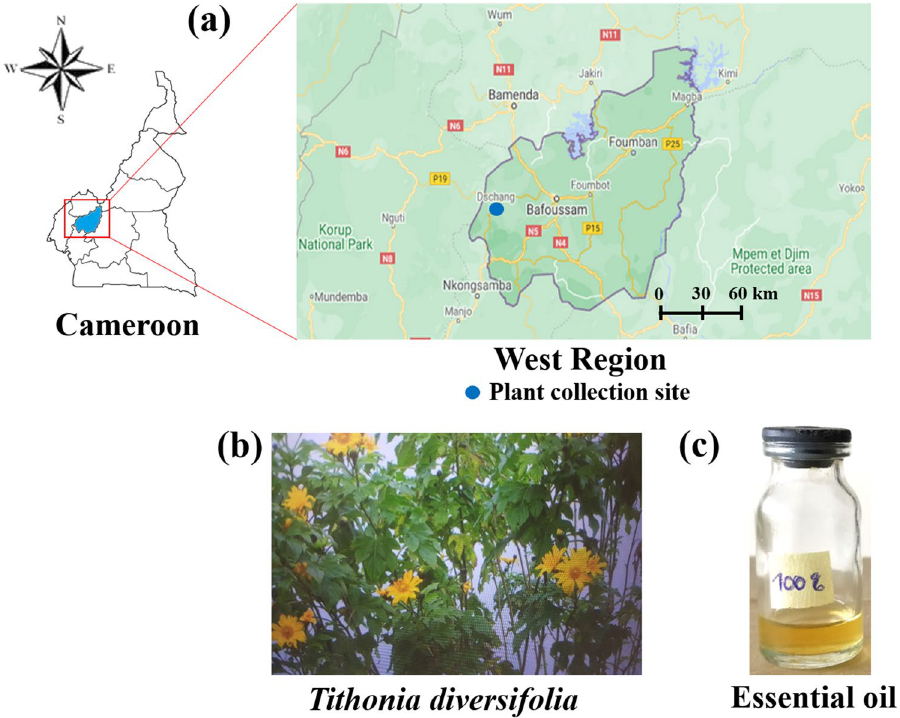
Figure 1. Map showing ( a ) the geographical area of collection, ( b ) T. diversifolia in its natural habitat, and ( c ) T. diversifolia essential oil-Photographs of the plants and its essential oil were provided by the